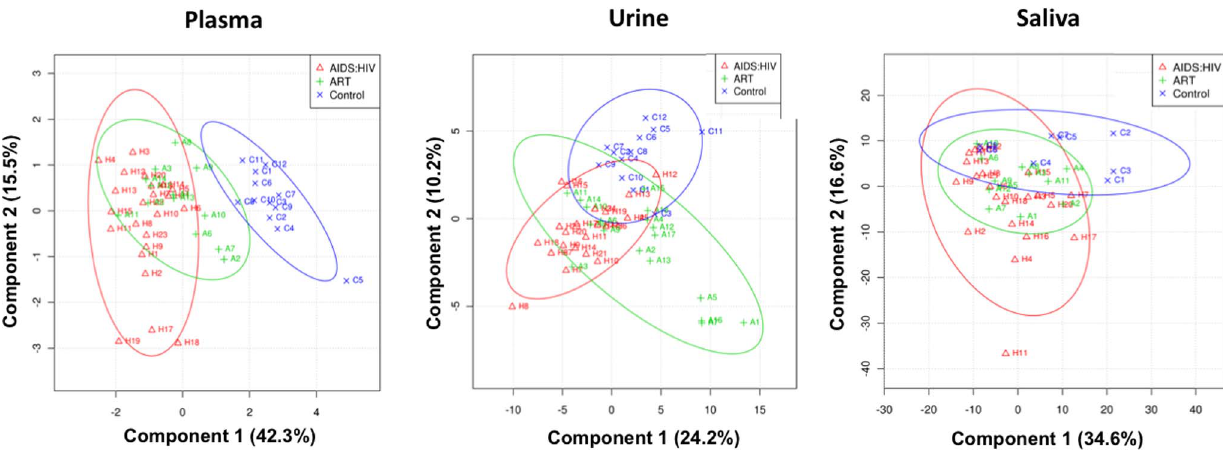
Figure 2. Parital least squares discrimination assay (PLS-DA) two-dimensional score plots developed from the 1 H NMR spectra of plasma, urine, and saliva collected from healthy control (X) and HIV/AIDS patients ( D ), and HIV/AIDS patients on ART ( +